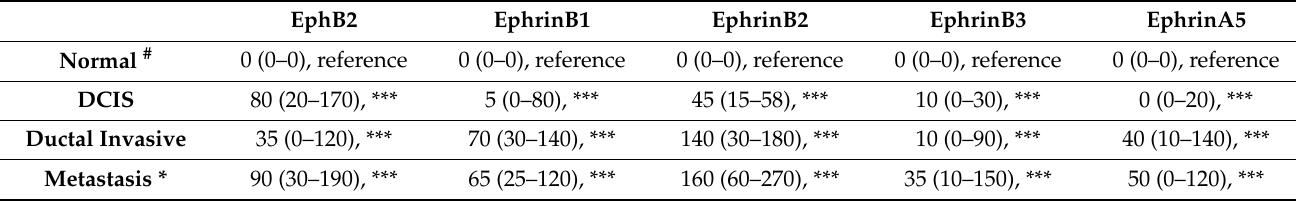
Table 2. A comparison of the median scores of different cancer progression categories within individual markers.